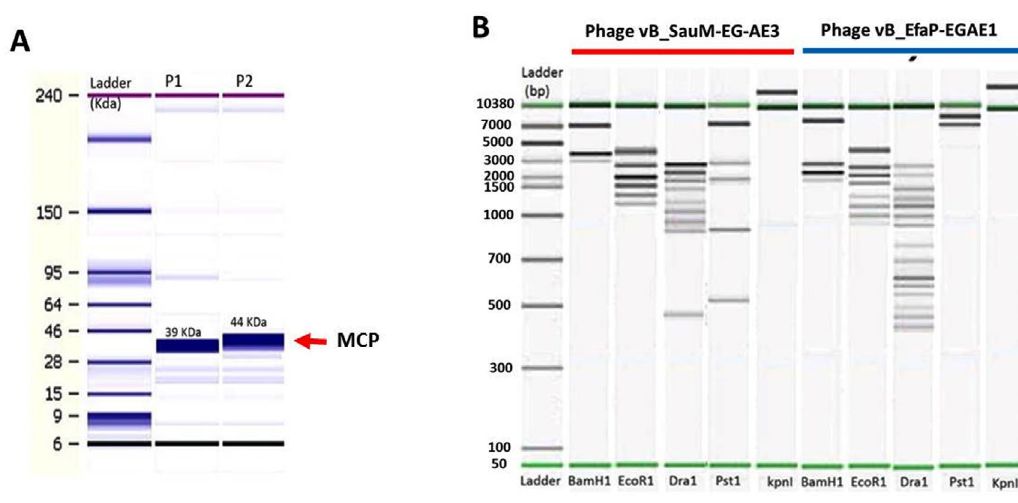
Fig. 4. Agilent bioanalyzer gel-like images of (A) SDS-polyacrylamide gel electrophoretic profiles of vB_ SauM-EG-AE3 and vB_EfaP-Ef01 structural proteins. Lane1: ladder ranged from 6 kDa to 240 kDa, lanes 2-3: Structural protein profiles of vB_SauM-EG-AE3 and vB_EfaP-Ef01 respectively, red rows represent the major capsid proteins of the isolated phages. (B) Restriction digestion profiles of the vB_SauM-EG- AE3 and vB_EfaP-Ef01 phages after digestion of DNA with BamHI, EcoRI, DraI, PstI, and KpnI. Lanes as shown on the figure, Ladder from 50 bp to 10380